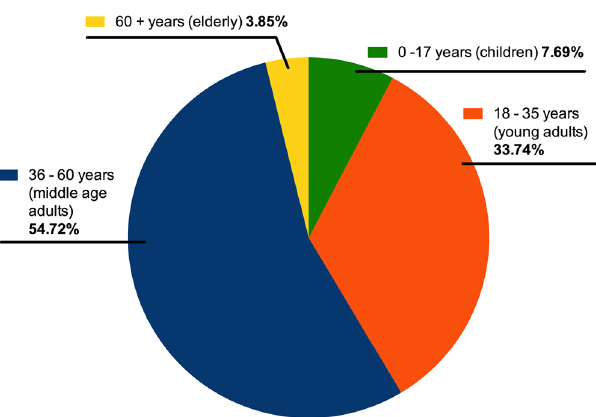
Figure 1. Age distribution of SARS-CoV-2 RT-PCR test. Middle-age adults represented 54.72% of SARS-CoV-2 positive persons, young adults 33.74%, children 7.69% and elderly 3.85%.